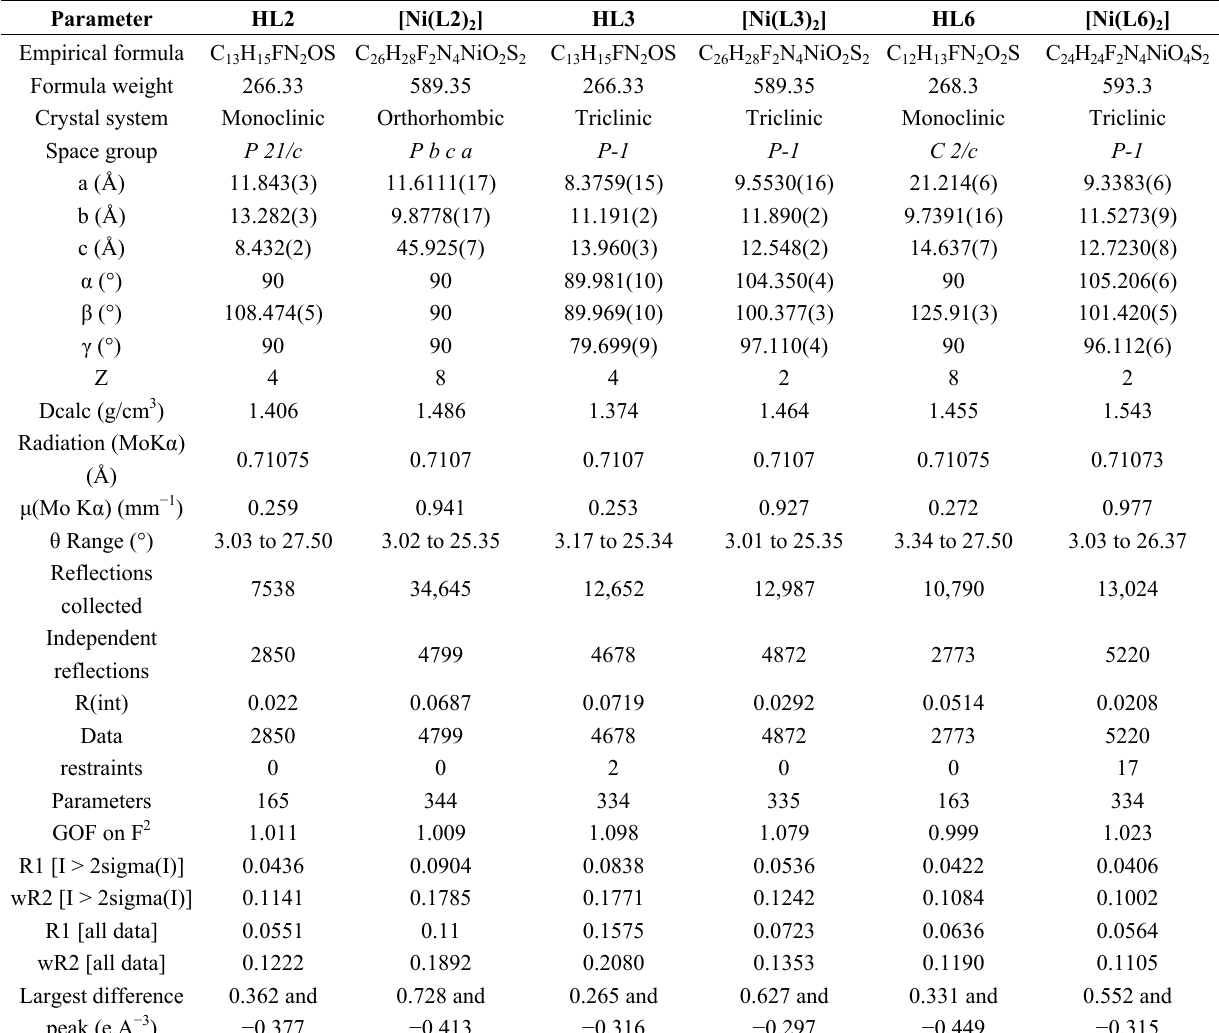
Table 1. Summary of X-ray diffraction